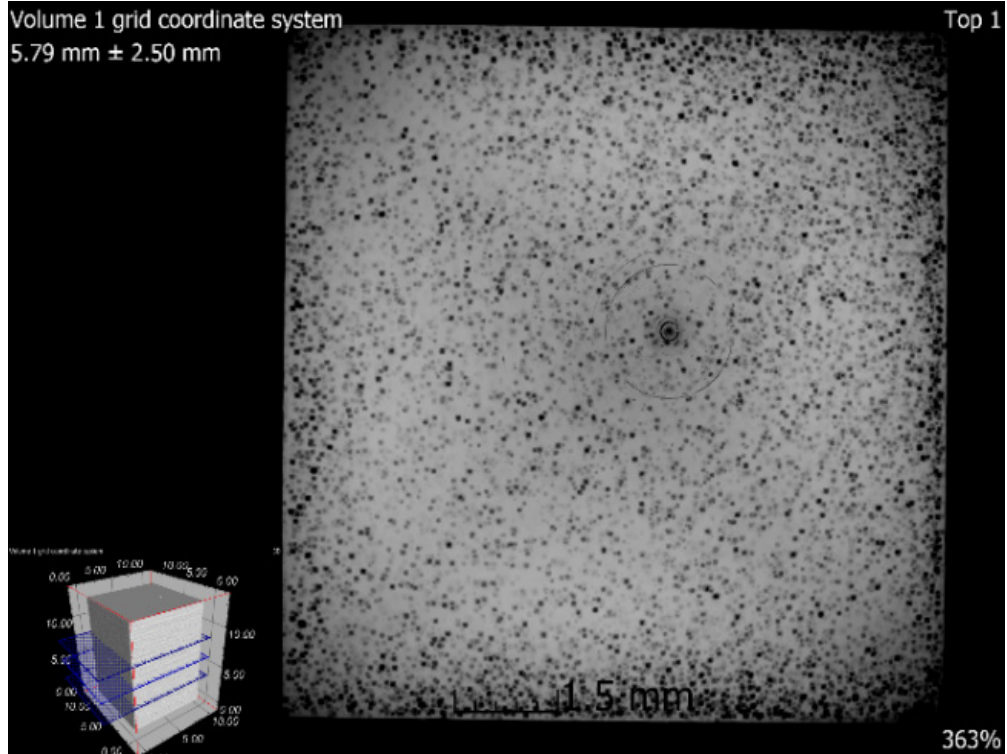
Figure 16. Tomographic CT sections of sample 5 after SLM (XY plane).